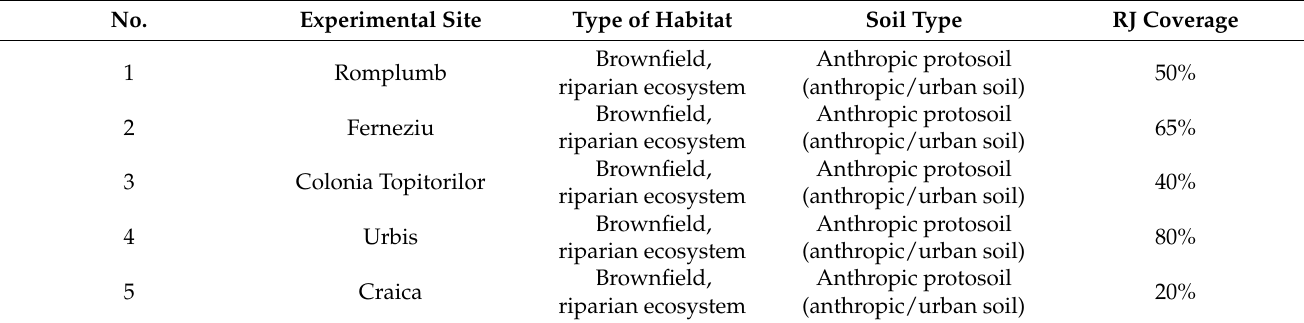
Table 1. Characterization of the experimental sites.